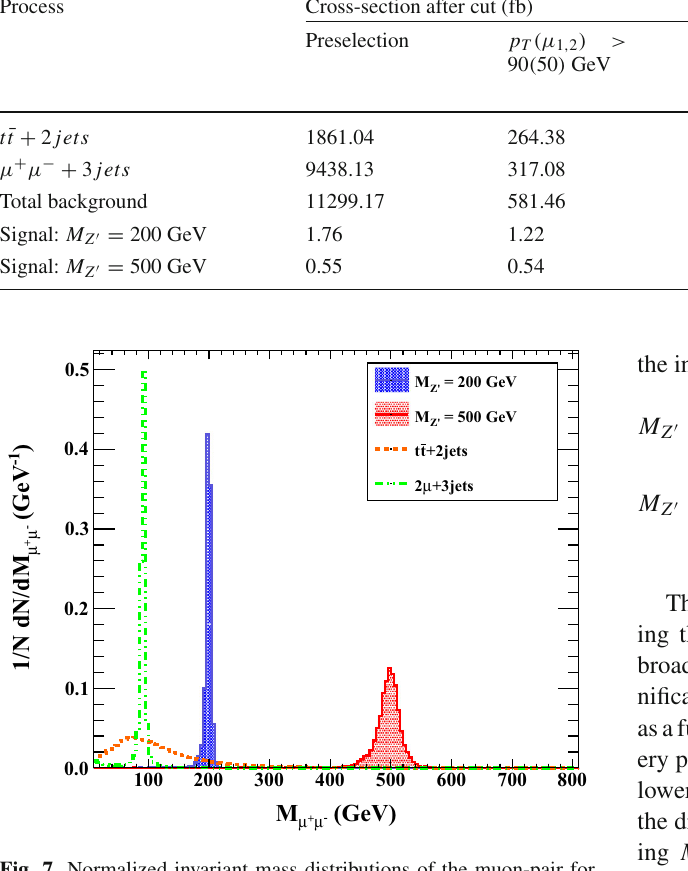
around the Z boson mass. The invariant mass distributions are depicted in Fig.